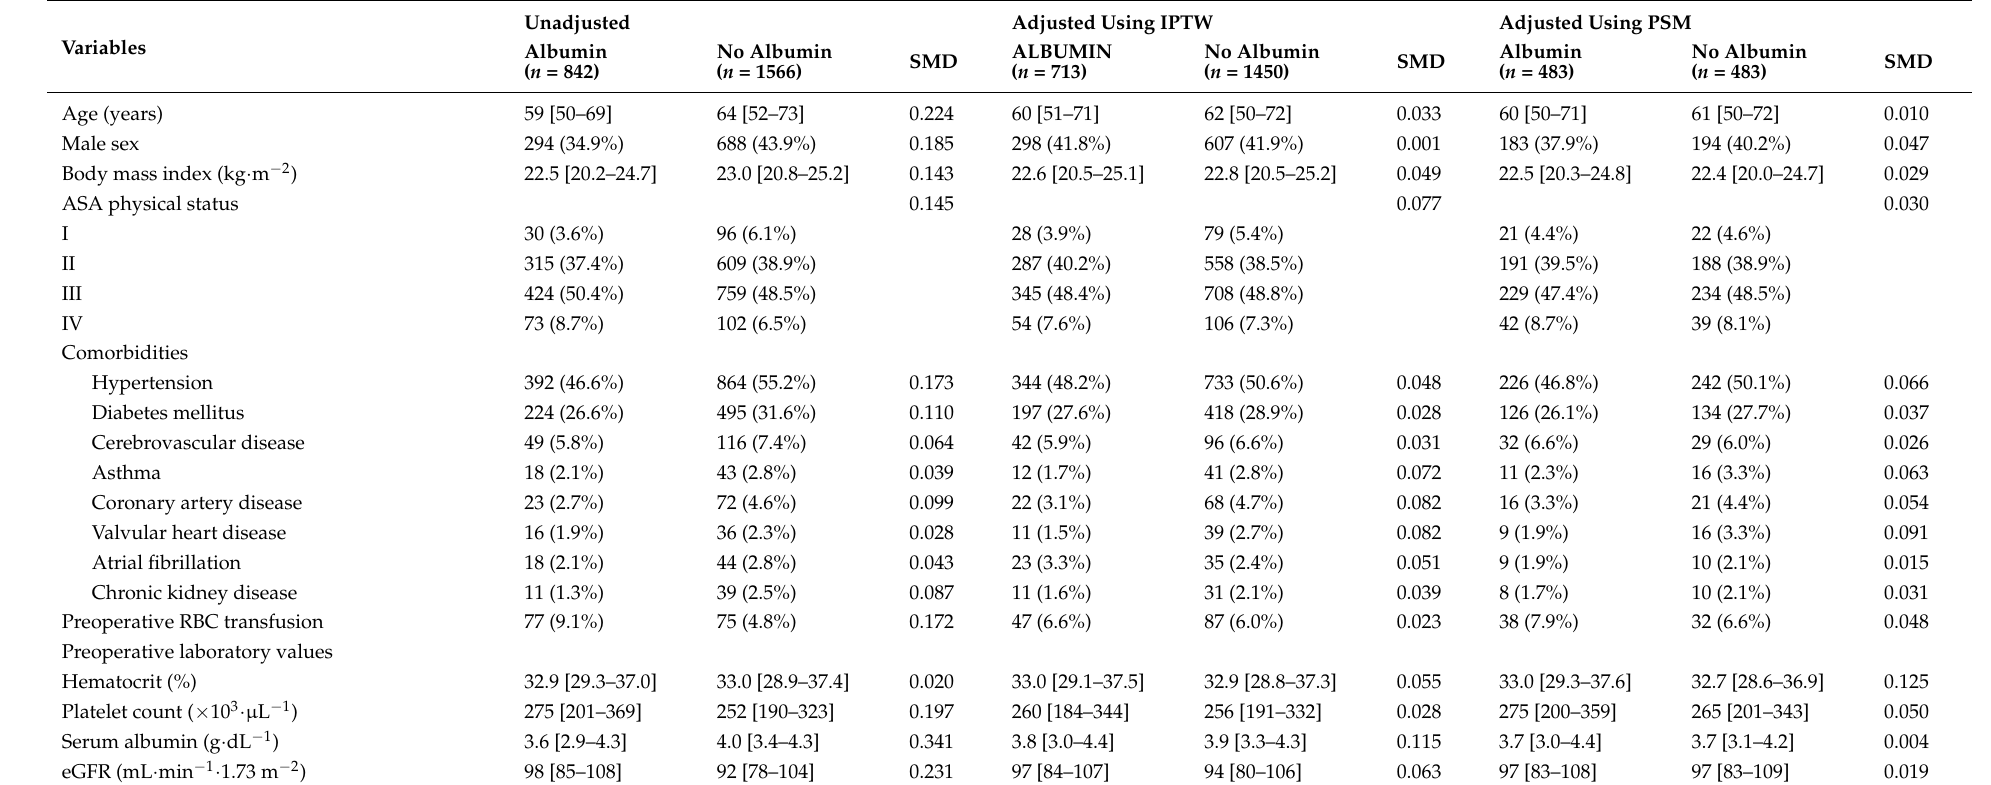
Table 1. Demographic and clinical characteristics in the unadjusted and adjusted